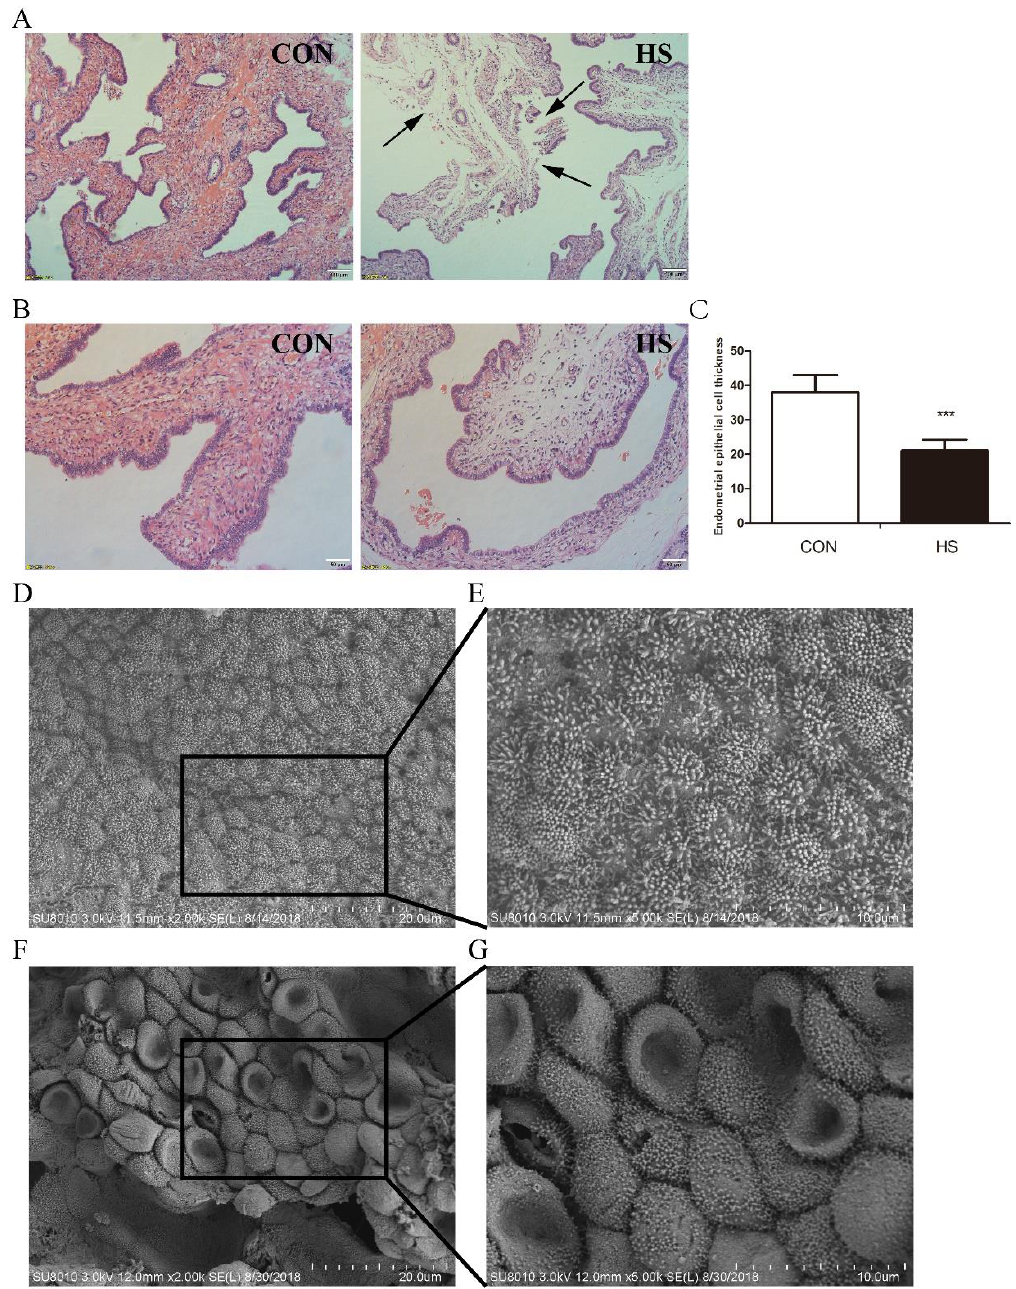
Figure 1. Effects of heat stress on the endometrium during embryo implantation. ( A , B ) Image of luminal epithelium at day 4 post heat stress (H/E staining) (scale bar, A 100 µ m; B 50 µ m). ( C ) Luminal epithelial thickness in the HS-treated group and the control group. *** p < 0.001. The data were expressed as means ± SD ( n = 5). ( D – F ) Scanning electron microscopy (SEM) images of uteri under heat stress. Uteri collected on day 14 of pregnancy were treated with heat stress (scale bar, 20μm). ( E – G ) High magnification (scale bar, 10μm).